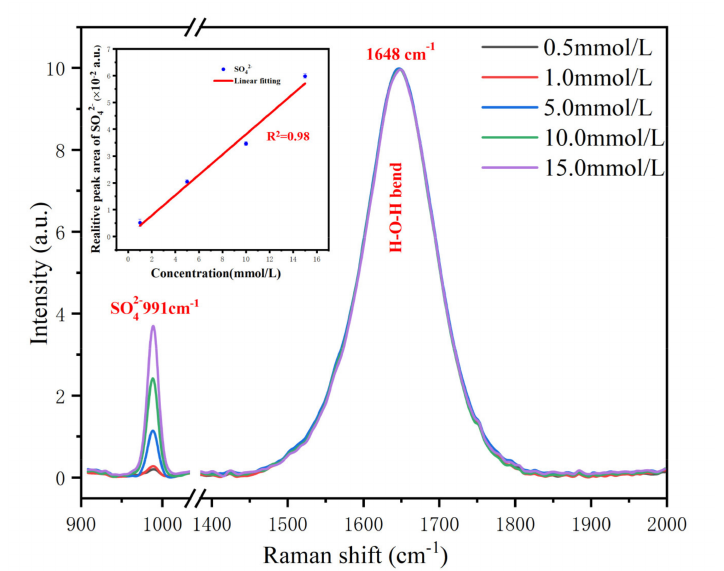
Figure 5. Raman spectra of Na 2 SO 4 solution with different concentrations (0.5–15.0 mmol/L) taken with 8 s integration. The insert shows the linear fitting